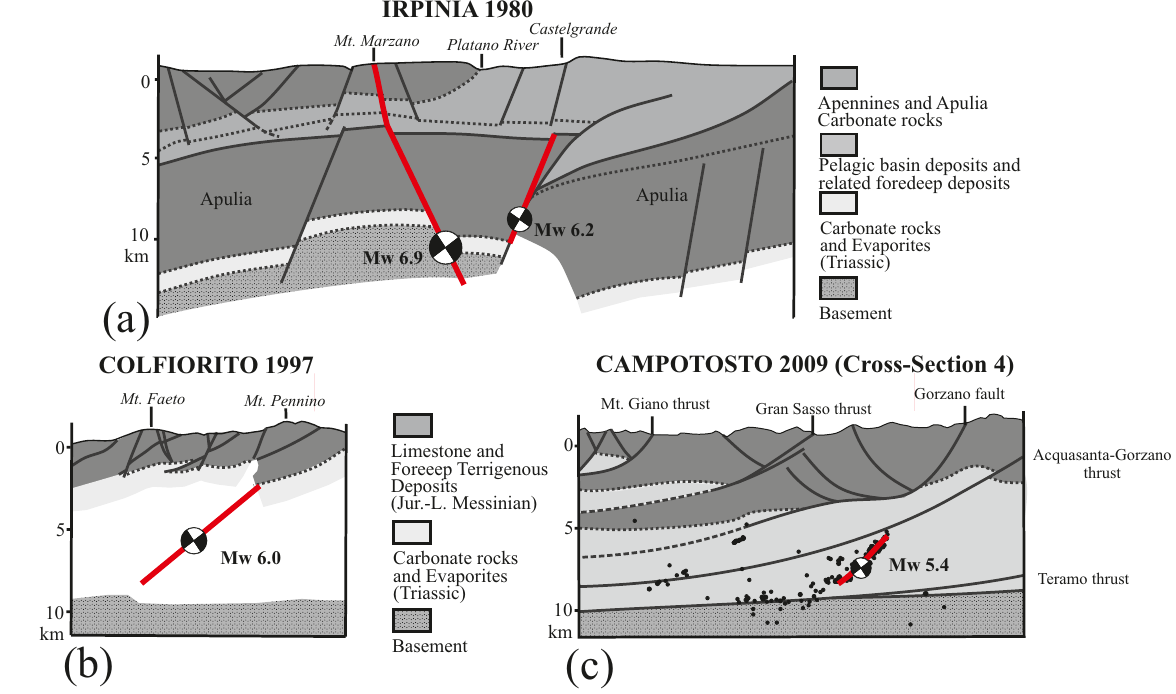
Figure 12. Geological cross sections across the causative faults of the 1980 Irpinia (modified from Mazzotti et al., 2007; faults from Pantosti and Valensise, 1990), 1997 Colfiorito (modified from Chiaraluce et al., 2005), and 2009 Campotosto (from Bigi et al., 2013) earthquakes. Thick red lines represent the seismogenic sources (Category